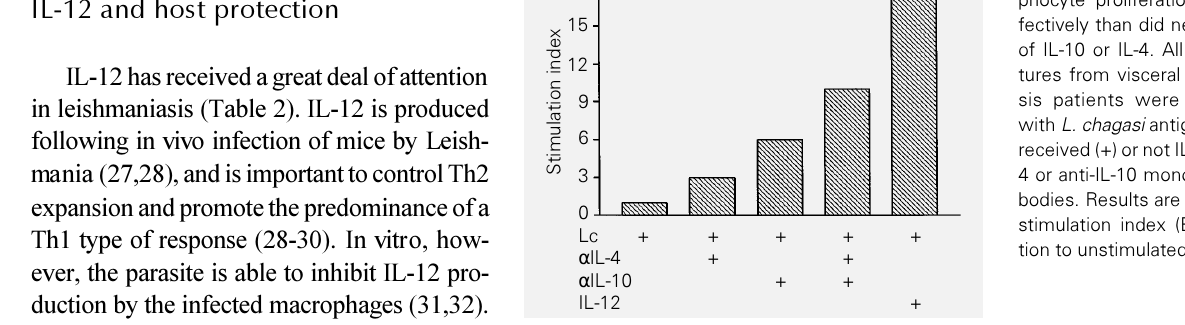
Figure 2 - IL-12 restored lym- phocyte proliferation more ef- fectively than did neutralization of IL-10 or IL-4. All PBMC cul- tures from visceral leishmania- sis patients were stimulated with L. chagasi antigen (Lc) and received (+) or not IL-12, anti-IL- 4 or anti-IL-10 monoclonal anti- bodies. Results are reported as stimulation index (E/C) in rela- tion to unstimulated